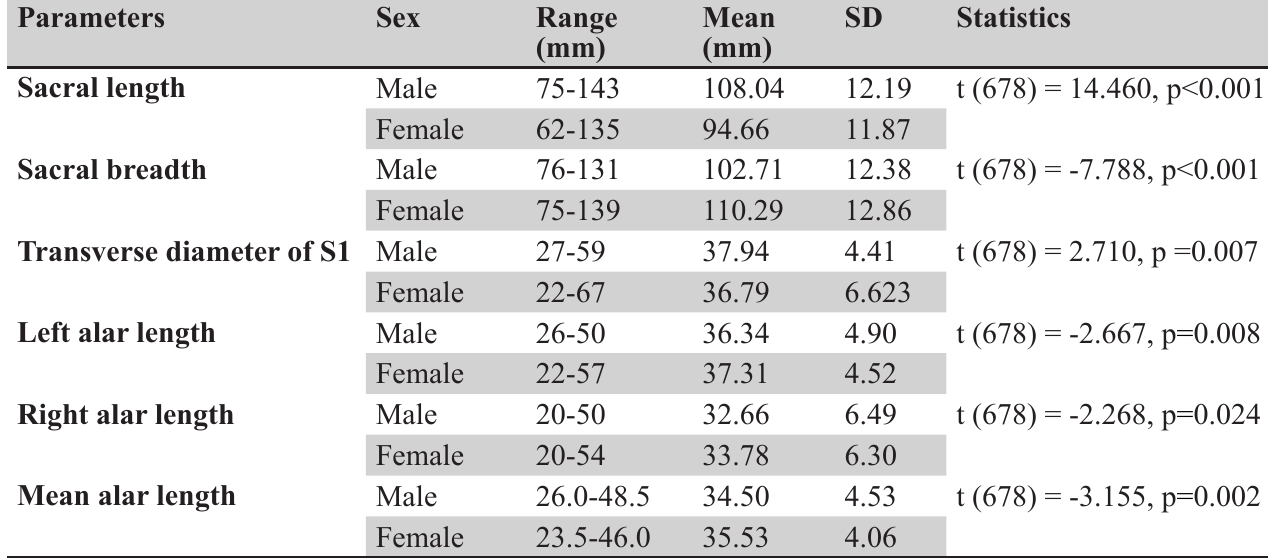
Table 1: Comparison of male and female sacral parameters. Parameters